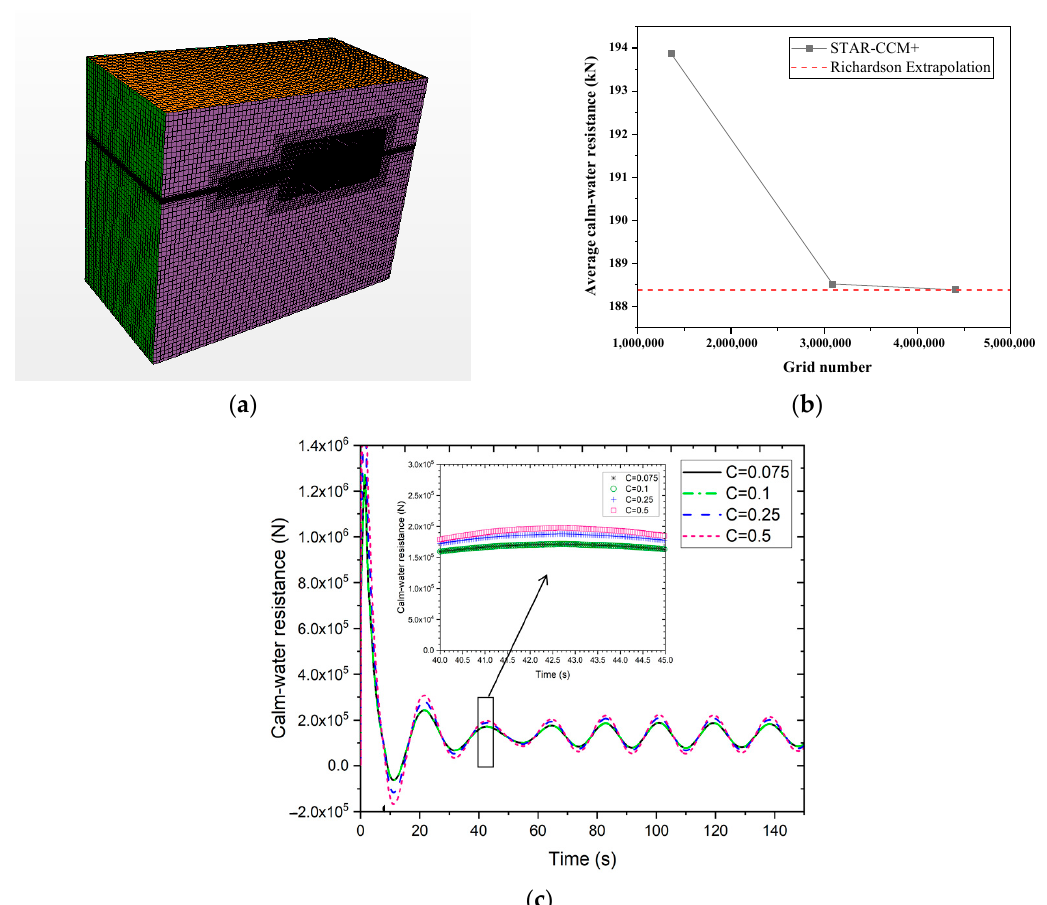
Figure 11. Numerical model and convergence study in the calculation of calm-water resistance, where ( a ) is the fluid domain extents and grid partition, ( b ) is the relationship of grid numbers to the average calm–water resistance and ( c ) is the time-step convergence study of the numerical calculations carried out with the Courant numbers, where C = 0.075, 0.1, 0.25, and 0.5,